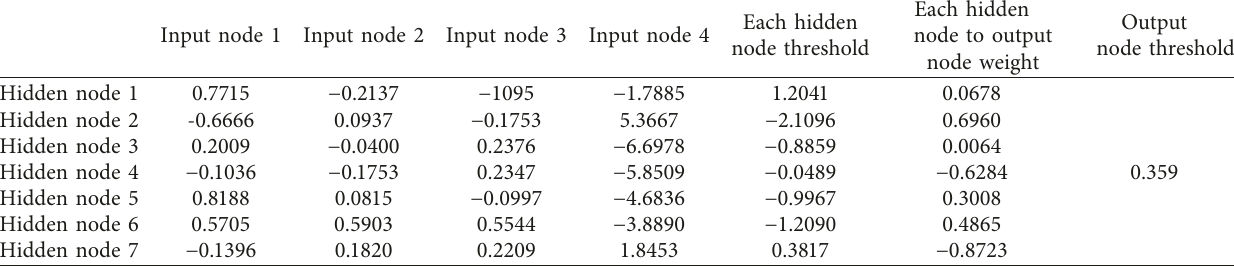
Table 5: The weights and thresholds of each node of the product occupancy neural network model.